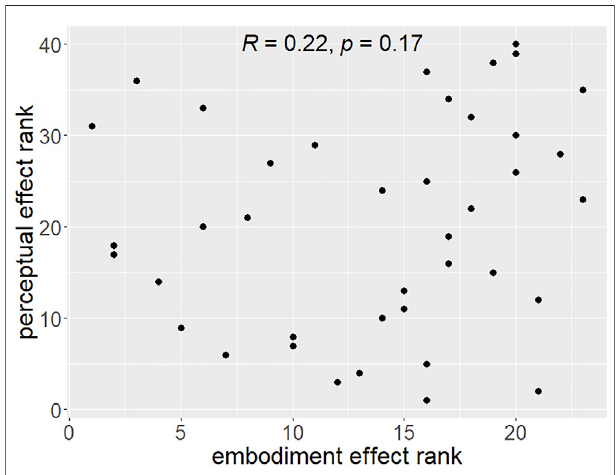
FIGURE 6 | Correlation plot between invisible body illusion (Q1-Q3) and perceptualeffect.Nosigni fi cantcorrelationwasfoundneitherwheninspecting the overall correlation across all questions nor per individual